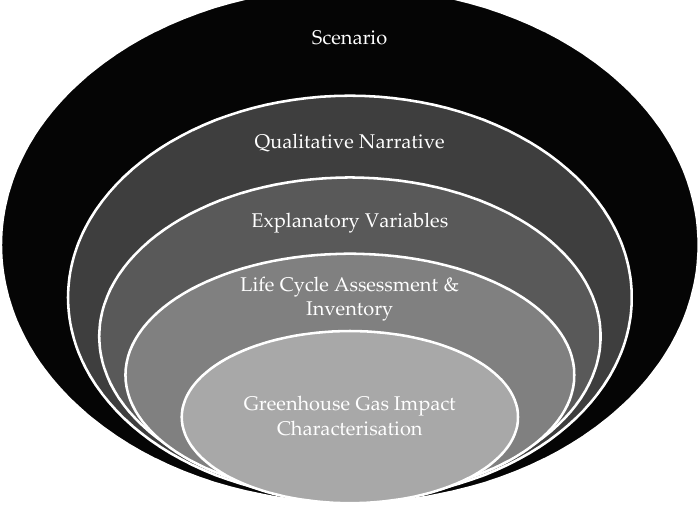
Figure 1. Schematic of research approach.